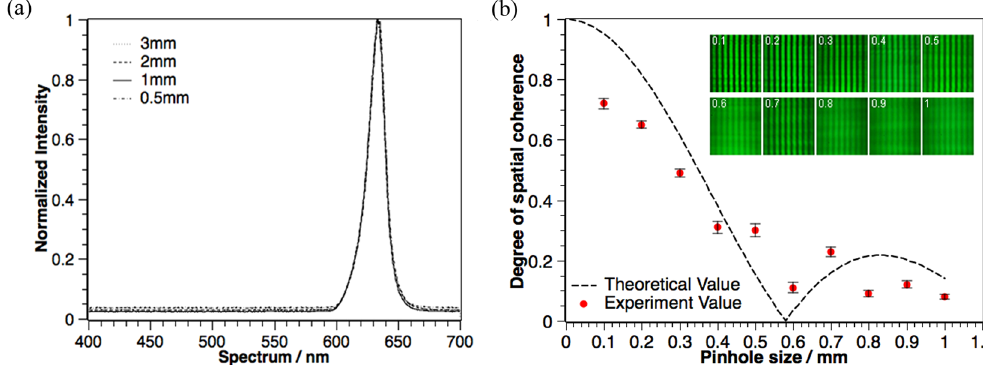
Figure 7. ( a ) The spectrum of LED filtered by different pinholes, and ( b ) the theoretical (black line) and experimental (red dots) spatial coherence value for different pinhole sizes. Top right graphs are the corresponding interference patterns.